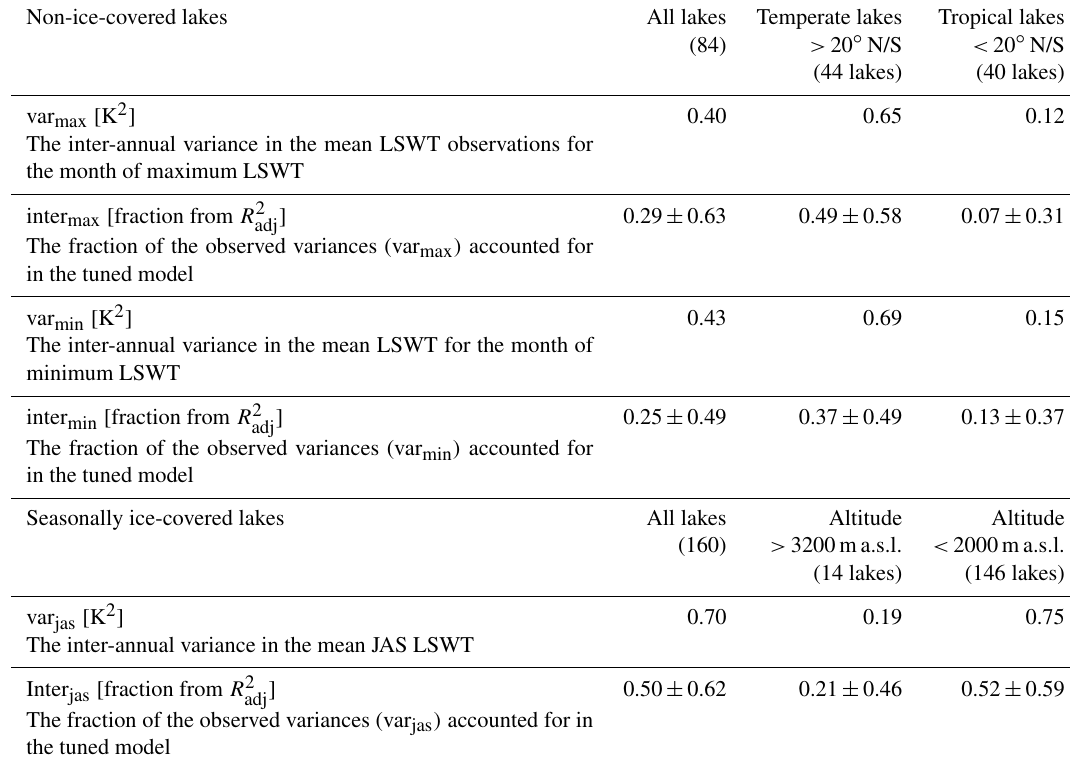
Table 9. The fraction of observed inter-annual variance detected in the model. Maximum and minimum LSWT is used for non-ice-covered lakes (inter max and inter min ) , while July–August–September (JAS) LSWTs are used for seasonally ice-covered lakes, (inter jas ) . This table highlights that where the observed inter-annual variance is low, the proportion of variance detected in the model is also low (high altitude seasonally ice-covered lakes and tropical lakes). Units are given in square